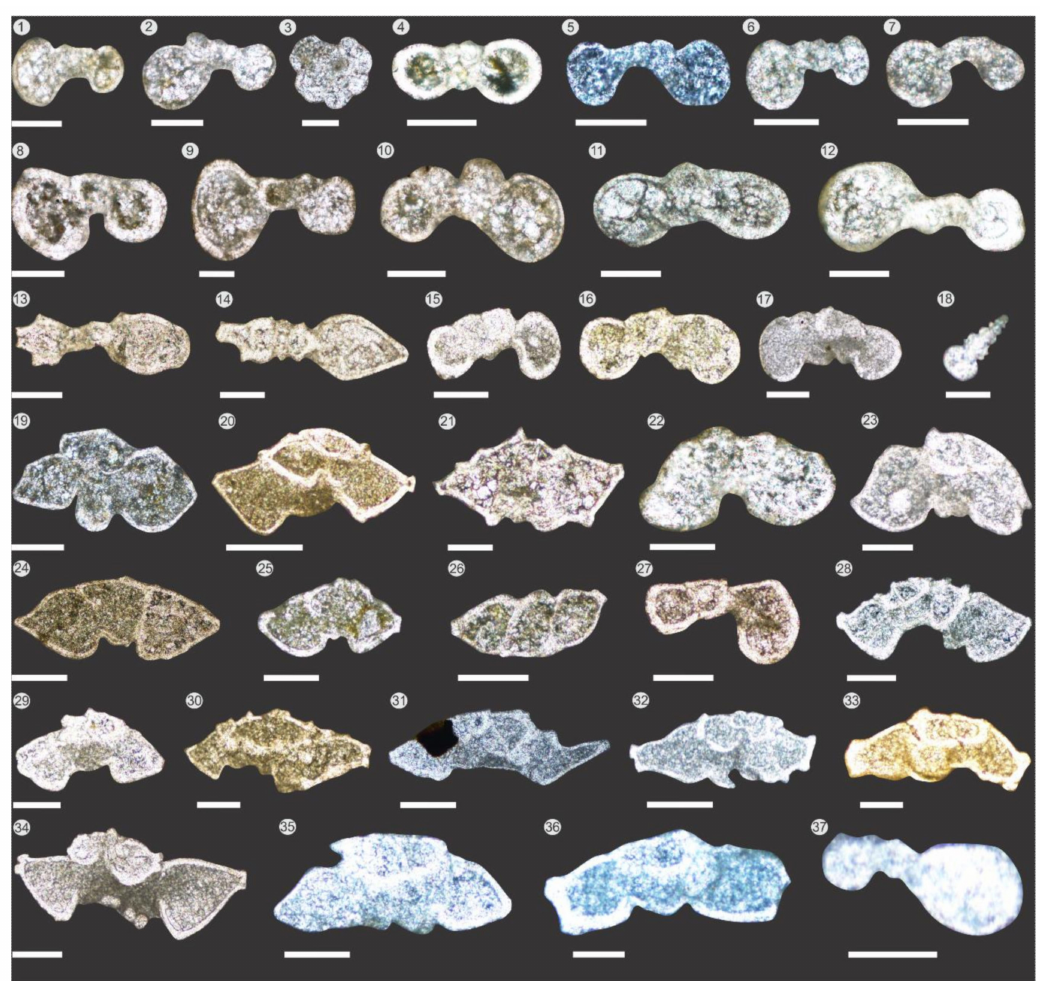
Figure 3. ( 1 ) Muricohedbergella planispira; ( 2 ) Muricohedbergella delrioensis; ( 3 ) Ticinella prim- ula; ( 4 ) Ticinella roberti; ( 5 ) Muricohedbergella simplex; ( 6 ) Muricohedbergella rischi; ( 7 )